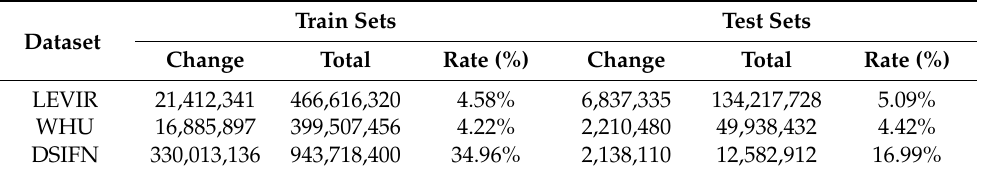
Table 8. The number of pixels in the change area on the three datasets. Train Dataset